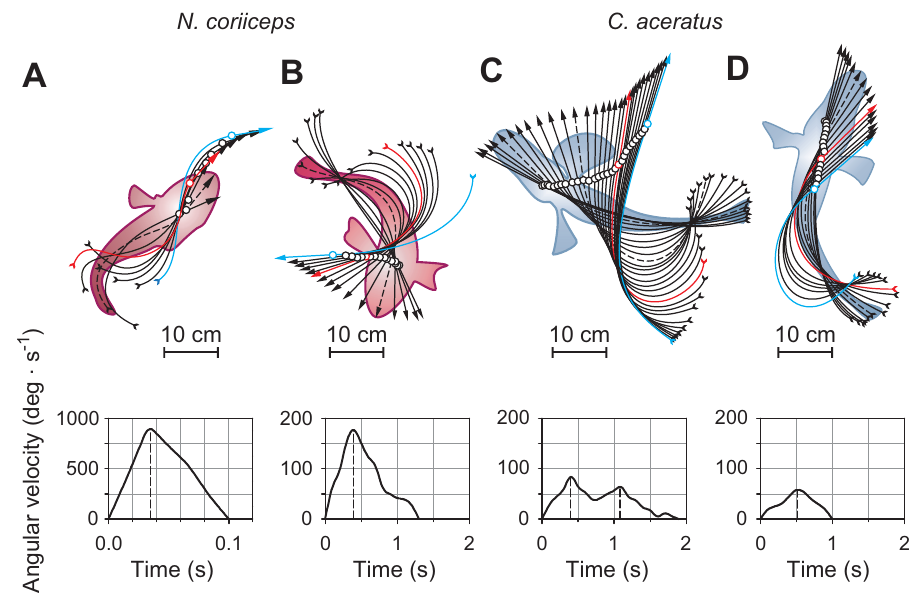
Fig 2. Repertoire of thermally induced startle-like maneuvers of Hb+ N . coriiceps and Hb- C . aceratus . (A) Fast S- bend turn of N . coriiceps (33 ms intervals) at +11.1˚C. (B) Intermediate velocity single-stage C-bend turn of N . coriiceps (100 ms intervals) at +12.4˚C. (C) Slow multi-stage C-bend turn of C aceratus (100 ms intervals) at +8.5˚C. (D) Withdrawal-like maneuver of C . aceratus (100 ms intervals) at +11.5˚C. Curved arrows and circles represent midlines and centers of mass of the fishes, respectively. Silhouettes with dashed midlines represent body-shapes and positions of fishes at maximal angular velocities during the turn stage of the maneuvers (dashed vertical lines in the time plots of angular velocity). Red midlines indicate completion of the first stage of the maneuver (namely, the S- or C-bend proper) and transition to the second stage, swimming or gliding without change in direction (shown as blue